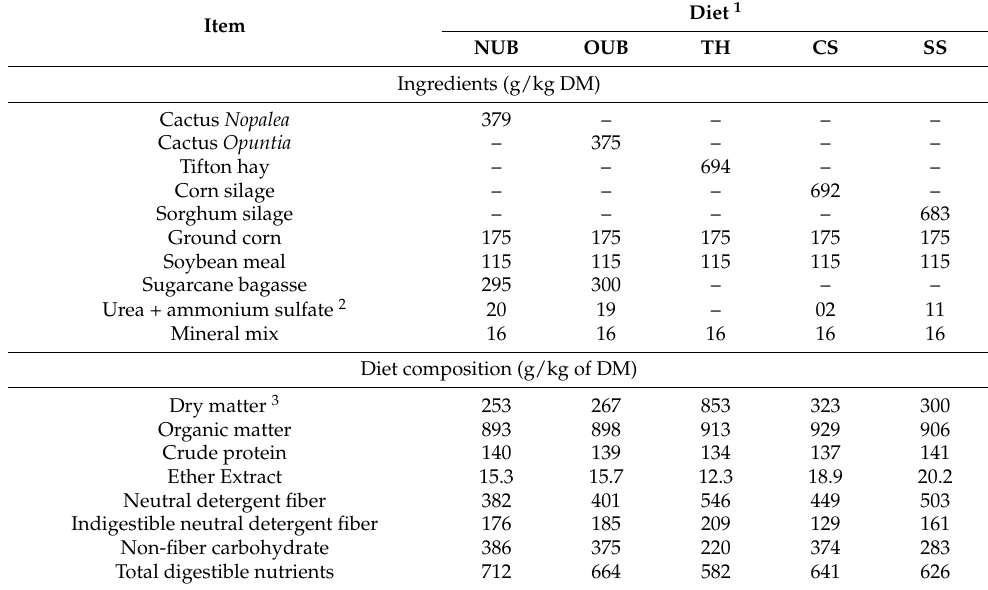
Table 3. Proportion of ingredients and chemical composition of the experimental